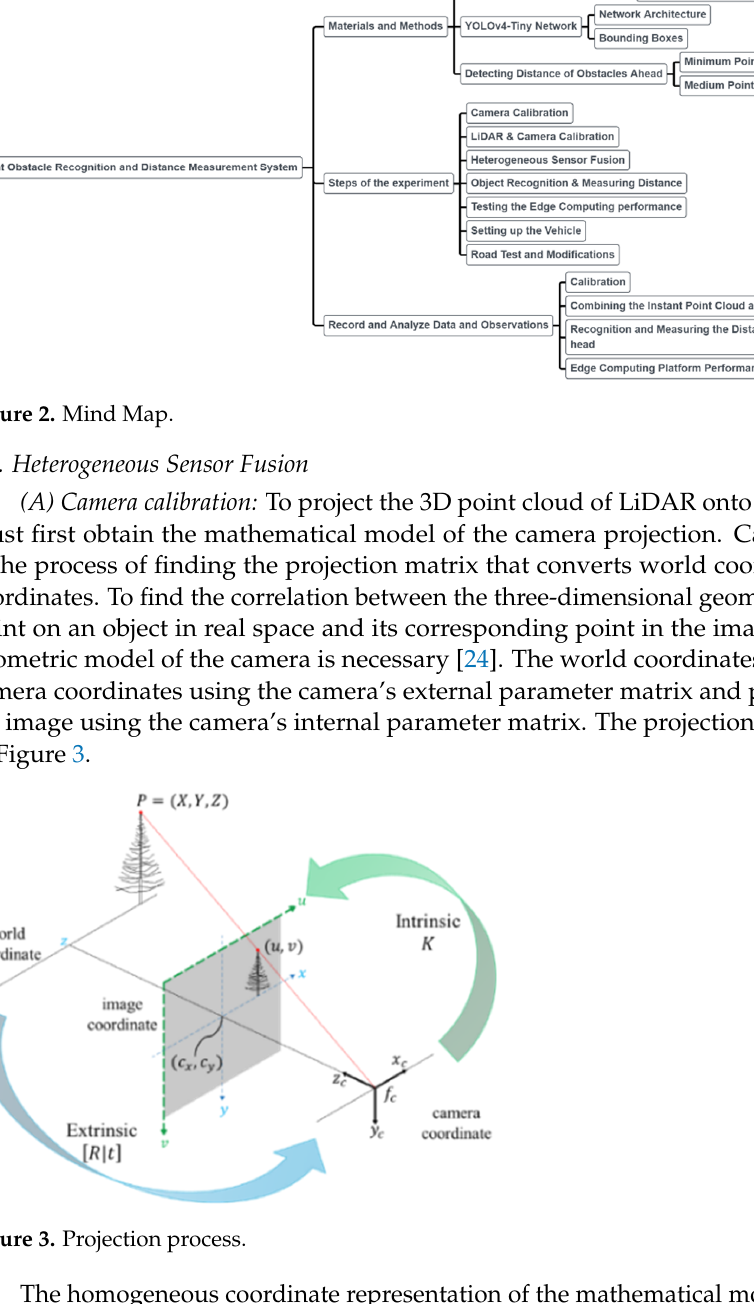
Figure 3. Projection process.